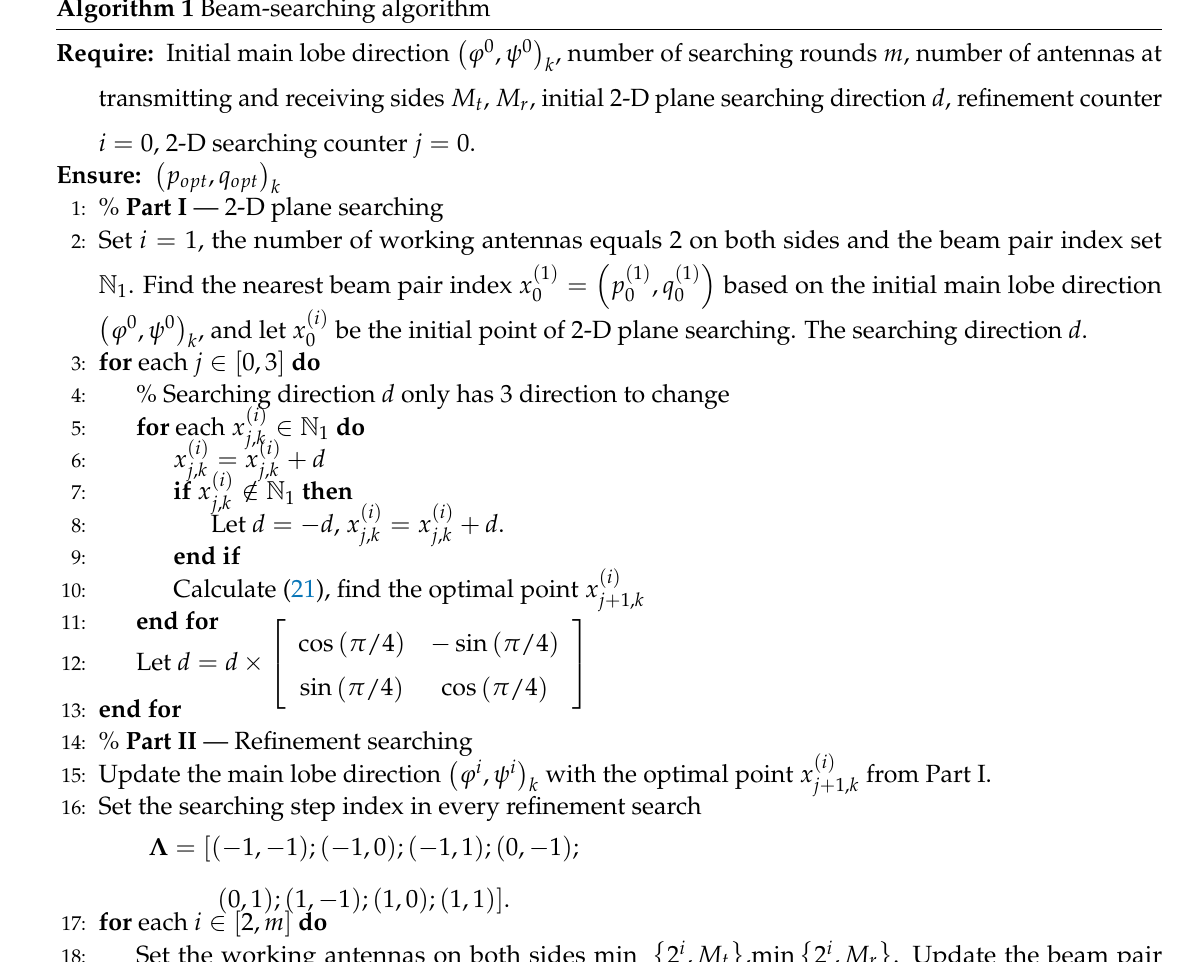
Algorithm 1 Beam-searching